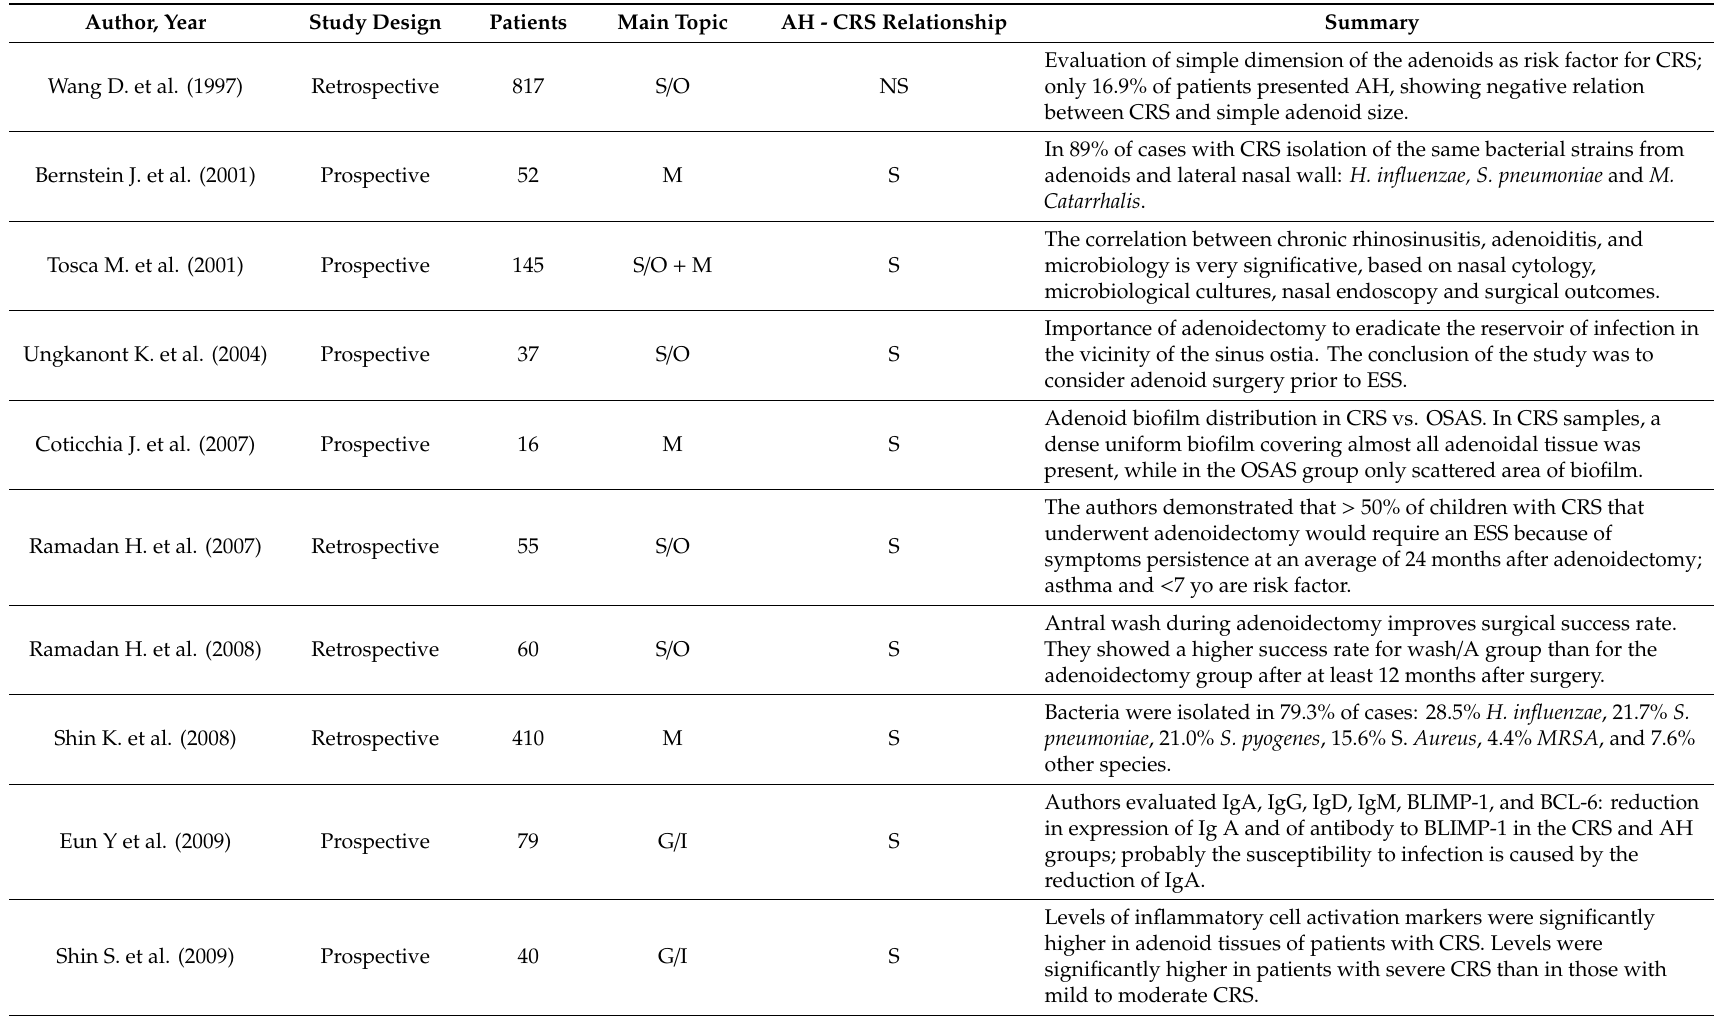
Table 1. Studies reporting results AH-CRS